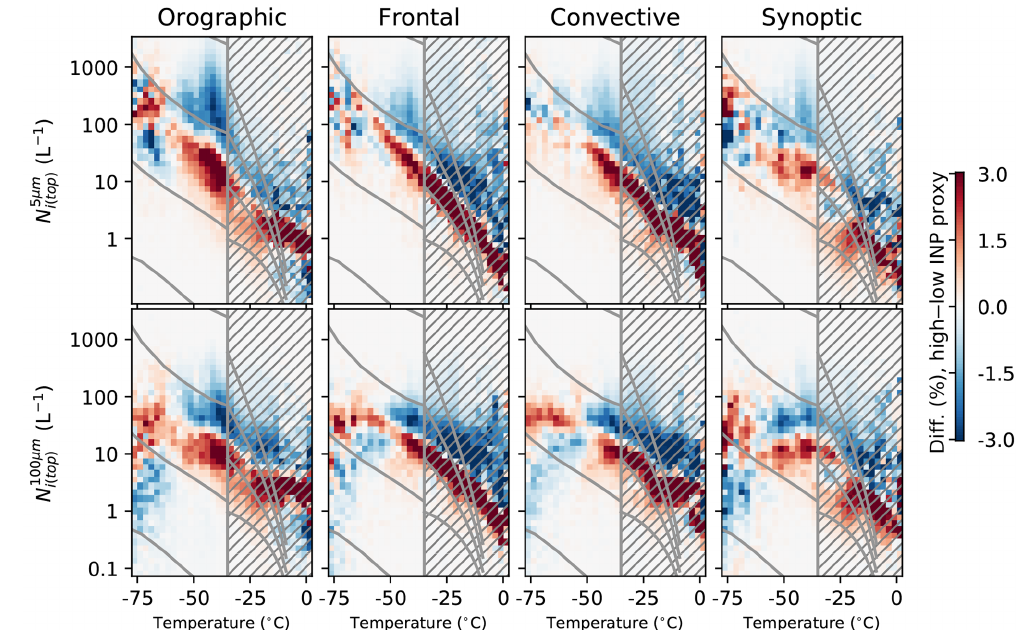
Figure 8. As in Fig. 6, but showing the difference in the conditional histograms as a function of the INP proxy. Red indicates an increase in the occurrence of a particular bin at a higher inferred INP and blue indicates a decrease, meaning that red above blue indicates an increase in N i ( top ) with increased INP for a given temperature. The shaded regions are likely affected by a phase misclassification at warmer